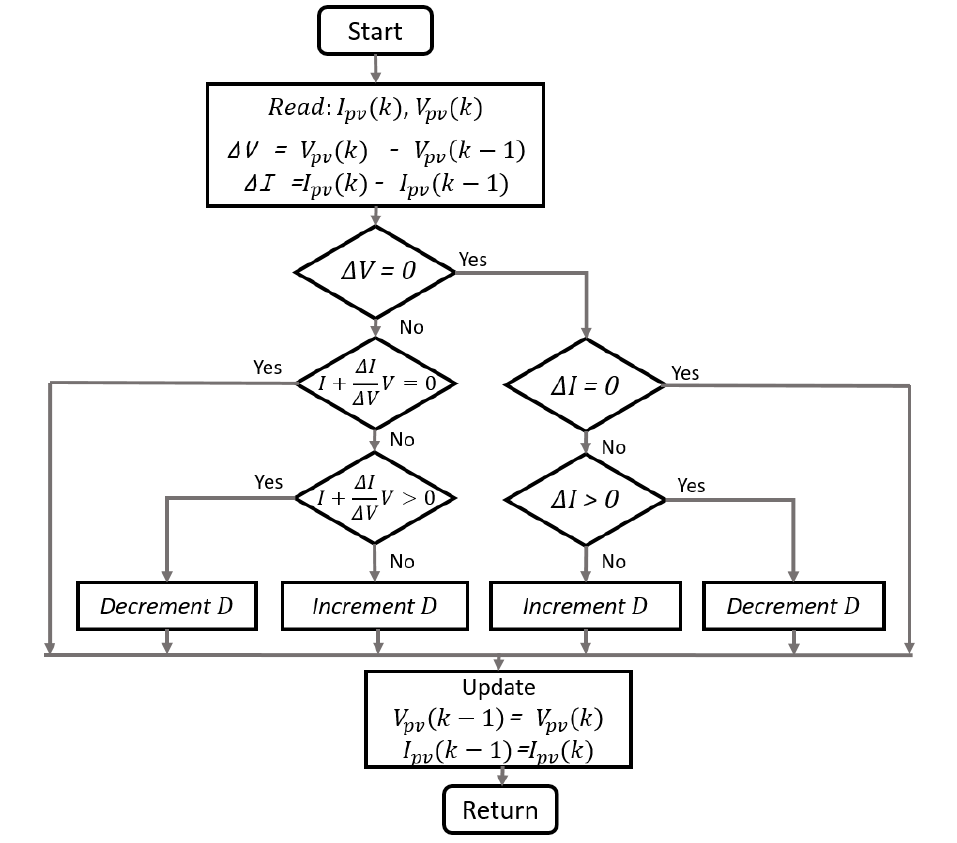
Figure 4. Flowchart of IncCond